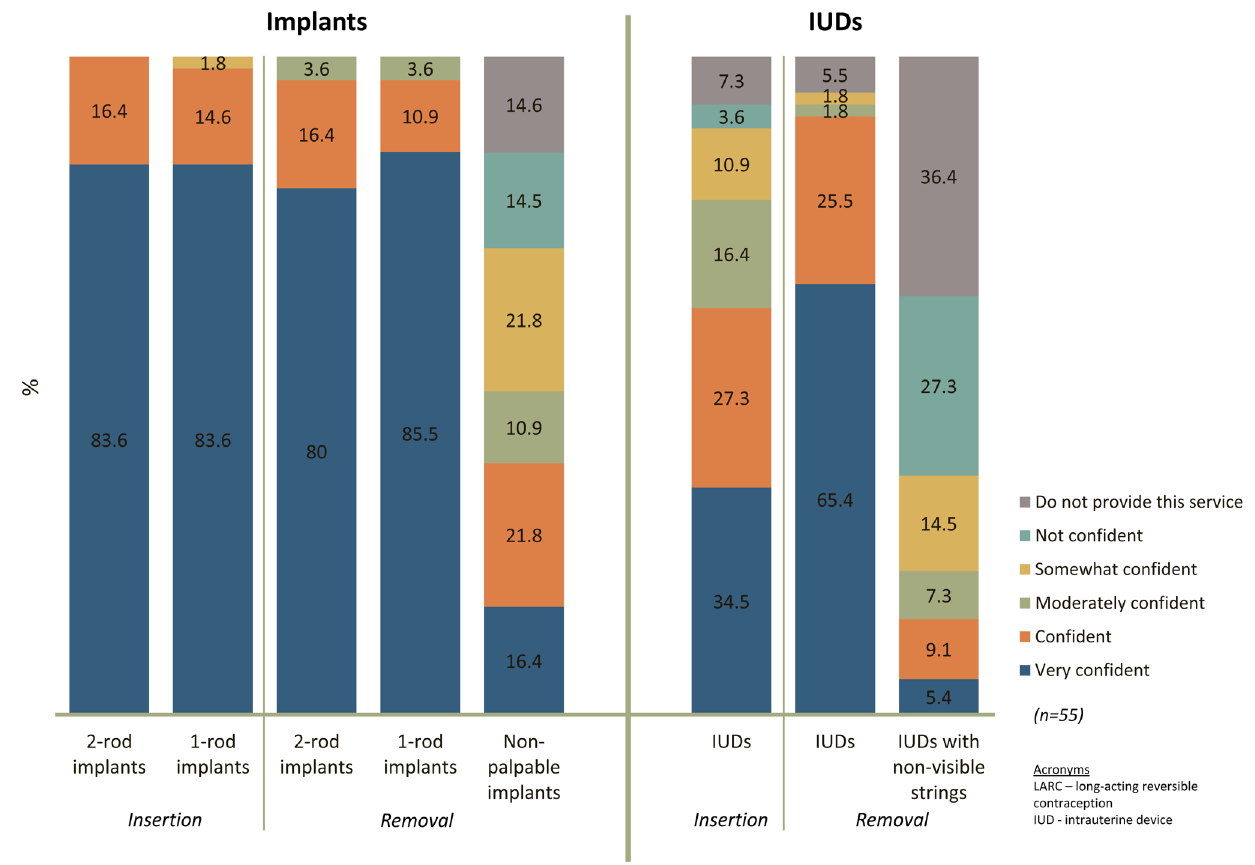
Figure 1. Self-reported confidence in inserting and removing LARCs, by